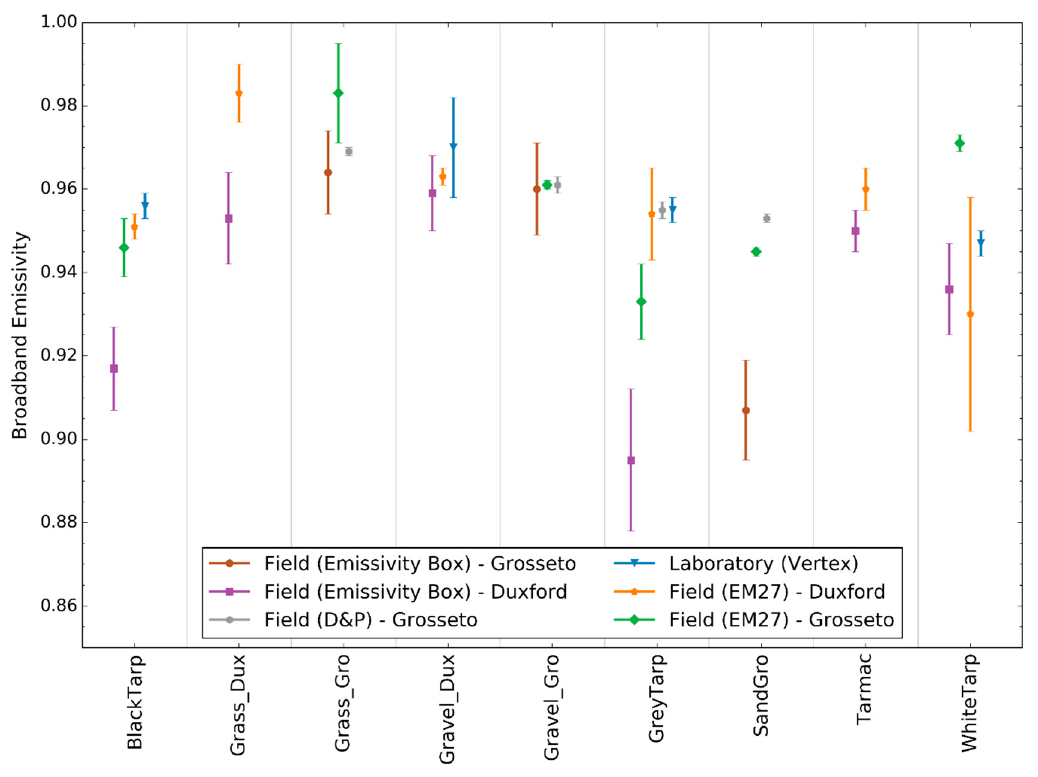
Figure 12. Broadband LWIR emissivities of target samples measured in Grosseto and Duxford by the EM27 and D&P FTIR systems, derived via the convolution of these surface spectral emissivity data with the spectral response function of the Heitronics KT15.85 radiometer shown in Figure 4. Matching broadband emissivity values derived using a two-lid emissivity box and that same Heitronics radiometer are shown alongside. Error bars show the uncertainties of each estimate.